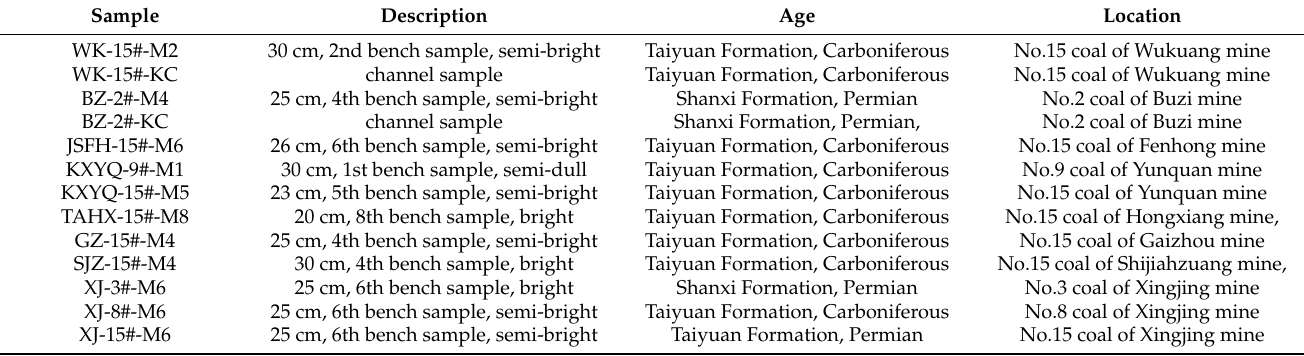
Table 1. Description for all